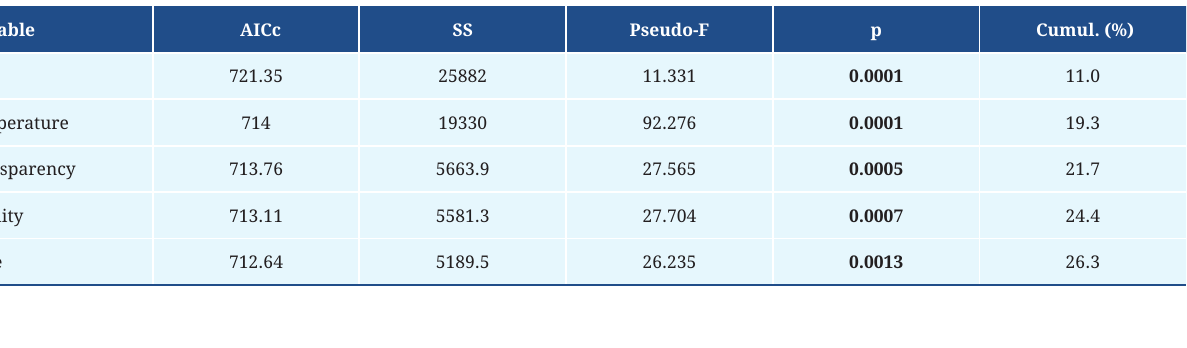
TABLE 3 | Summary of results from analysis, conducted with the distance-based, nonparametric linear modeling of the relationship between structure of shallow water fish assemblages and predictors sampled from May 2000 to April 2001 in the north-south axis of the Paranaguá Bay Estuarine Complex (southern Brazilian coast). D = distance from the mouth of the estuary. Time = succession of days from beginning to end of the sampling surveys. AICc = corrected Akaike information criterion, Cumul. (%) = cumulative percentage of the variability of the fish assemblage structure explained by the model, SS = sum of squares, Pseudo-F = statistic test, p = p-value associated to Pseudo-F. Significant values are in bold.